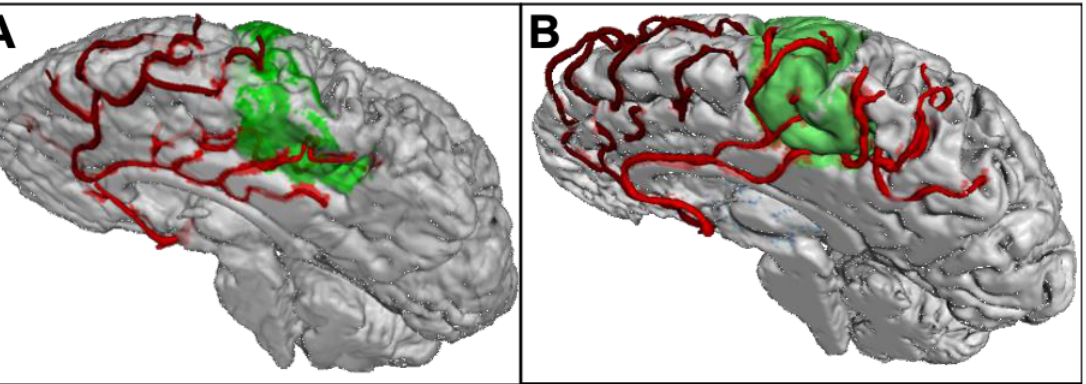
Figure 1. Vascular supply patterns of the motor cortex through the anterior cerebral artery in healthy young controls. ( A ) “Double supply” pattern in the medial motor cortex by branches of the pericallosal artery (light red) and callosomarginal artery (dark red). ( B ) displays a “single supply” pattern in the medial motor cortex by branches of the pericallosal artery only (light red). The motor cortex is colored green. Volunteers received 7T MPRAGE scans; vessels were manually delineated; the motor cortex was segmented using Freesurfer.